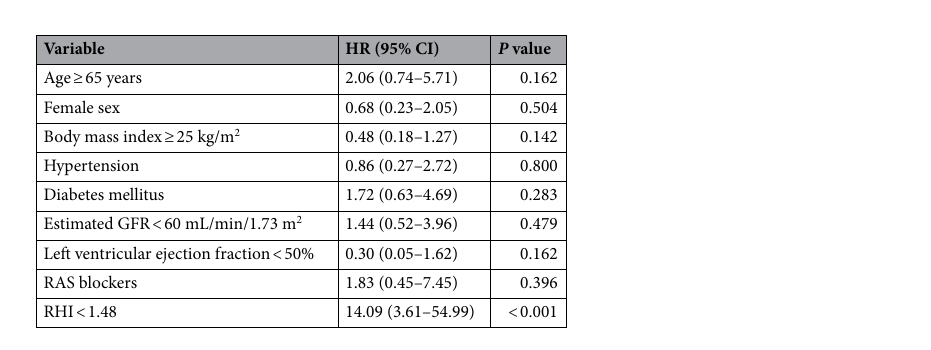
Table 3. Multivariable analysis showing an independent association between RHI and occurrence of clinical events. RHI reactive hyperemic index; HR hazard ratio; CI confidence interval; GFR glomerular filtration rate; RAS renin-angiotensin